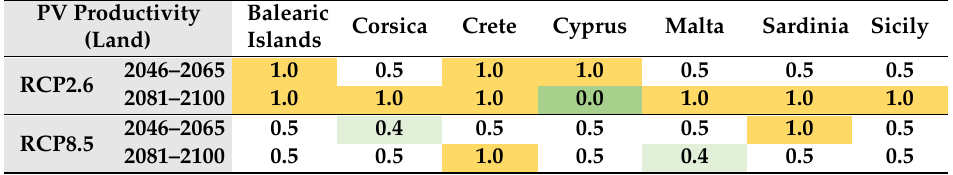
Table A4. Normalized uncertainty (Nu) for PV productivity for each island, scenario and time period. Deep green cells: Nu = 0–0.2; Light green: Nu = 0.3–0.4; White: Nu = 0.5; light yellow: Nu = 0.6–0.7; Deep yellow: Nu = 0.8–1. Nu is computed over land.